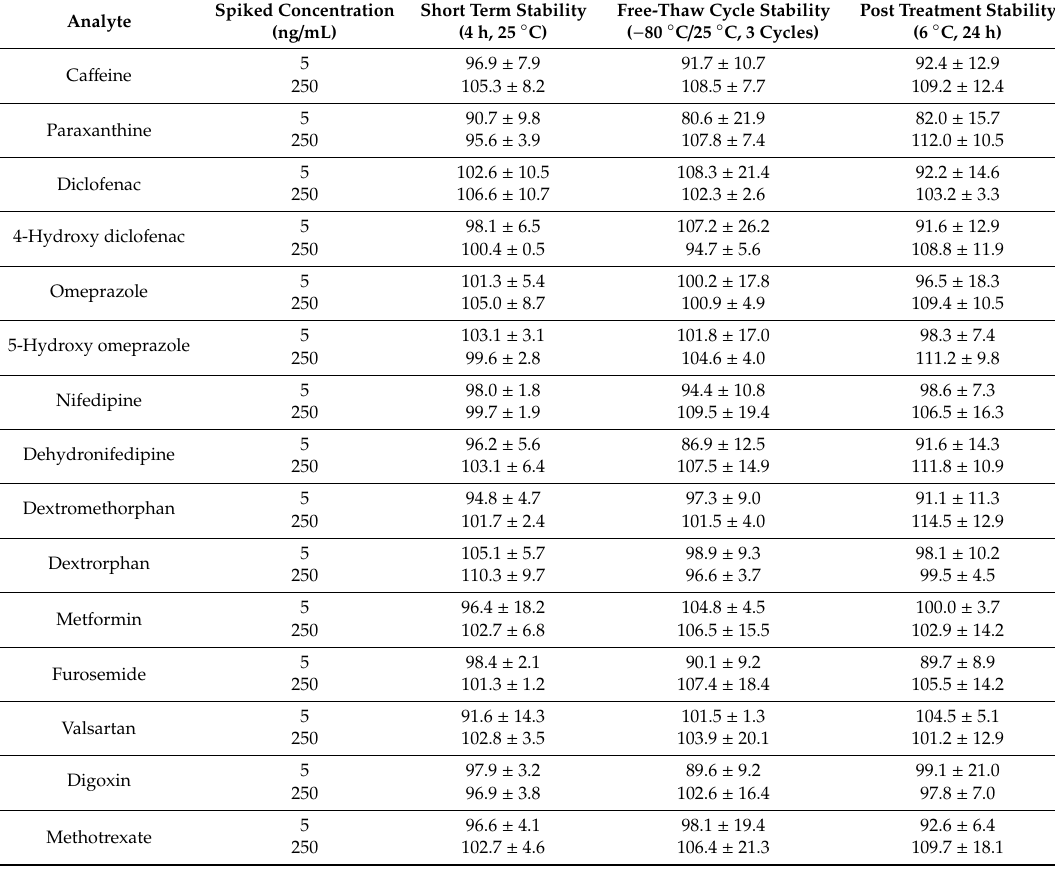
Table 4. Short-term, freeze-thaw cycle, and post-treatment stability of 15 probe substrates and metabolites.